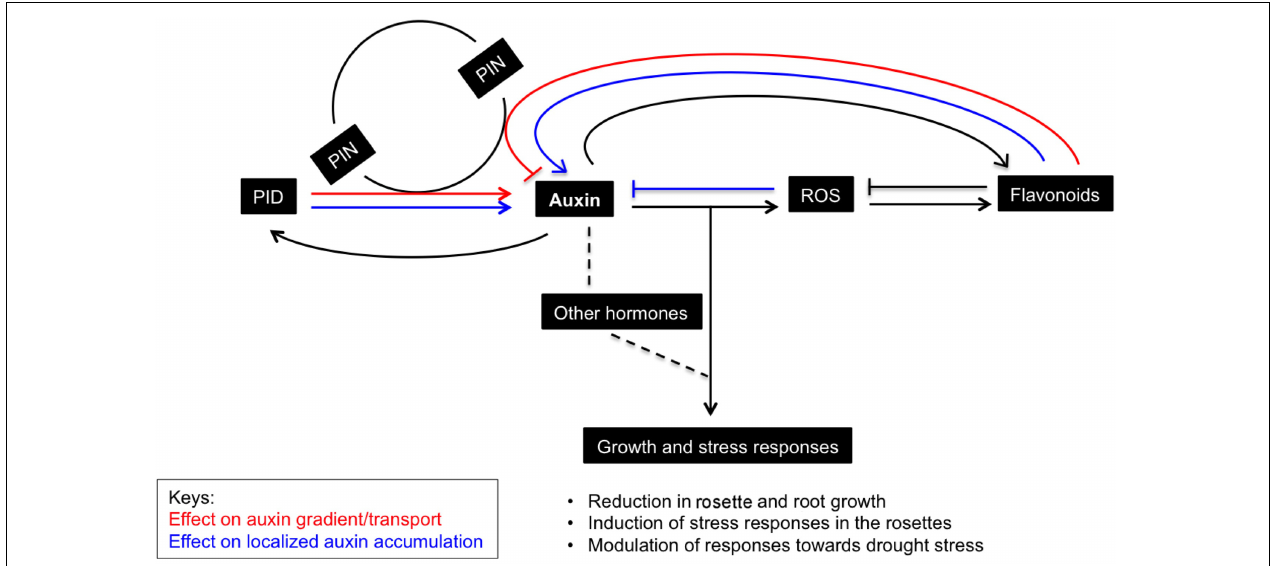
FIGURE 7 | Schematic representation of the effects of PID-modulated auxin homeostasis and signaling on rosette growth and stress responses. PID , an early auxin responsive gene and a regular of PIN polarity and auxin transport, causes accumulation of auxin in the rosettes when it is ectopically expressed. The perturbation in auxin homeostasis and signaling affects levels of other interacting hormones and leads to ROS generation, which is known to promote oxidative degradation of auxins. Consequently, flavonoids accumulate to curb ROS and inhibit auxin transport, and supposedly further promote auxin retention in the leaves. This results in growth retardation and increased sensitivity toward drought stress in Arabidopsis plants. Factors affecting the auxin gradient and localized auxin accumulation (here in leaves) are marked in red and blue,